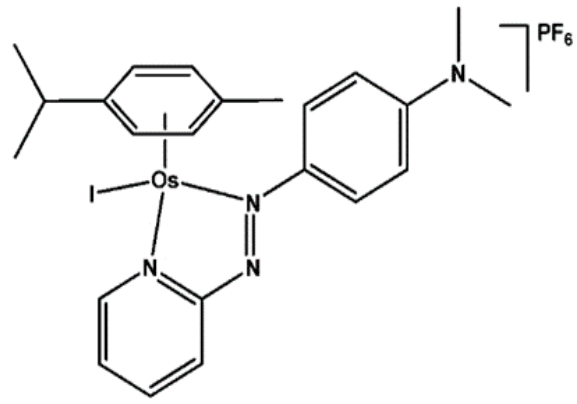
Figure 15. The structure of osmium(II) complex [93].